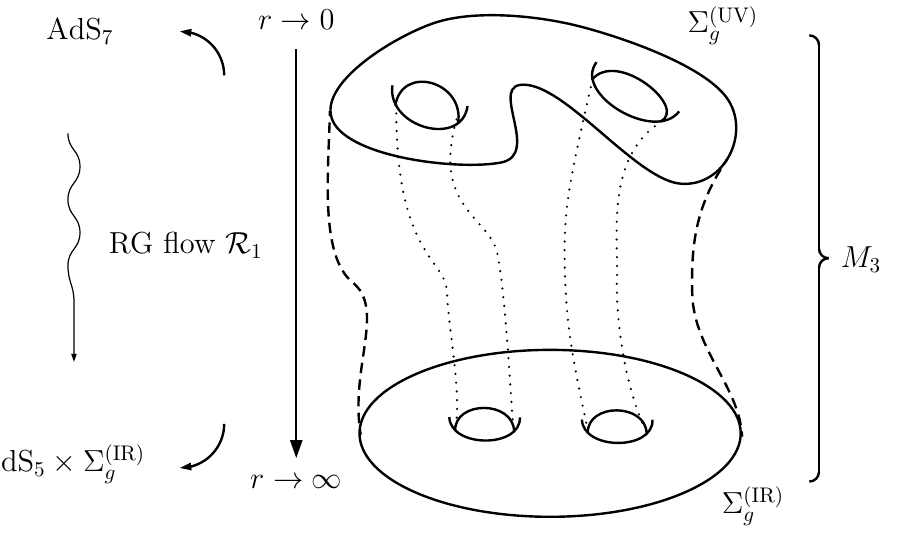
Figure 1 . A schematic sketch of the holographic renormalization group (cid:13)ow (top) AdS 7 , whose slices at (cid:12)xed radial coordinate r are given by R 3 ; 1 (bottom) AdS 5 (cid:6) (IR) g (cid:12)xed points. The cobordism, M 3 is given by the evolution of the geometry (cid:2) of the Riemann surface along the (cid:13)ow. Furthermore, as showed in [4], the metric on the Riemann surface \uniformizes" in the infrared.